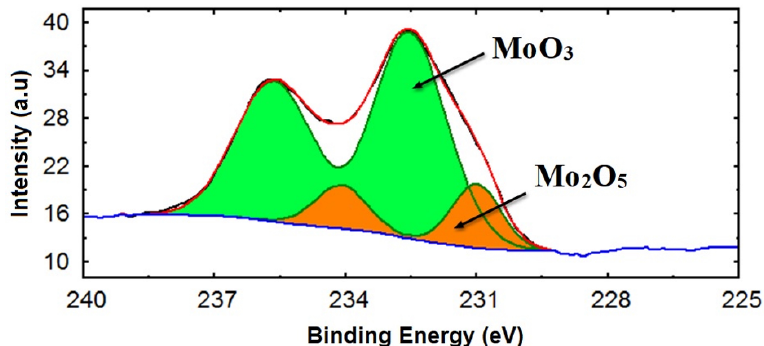
Figure 7. Individual XPS spectra of molybdenum in the coating on a steel substrate (duration of the process ( τ ) = 8 min)